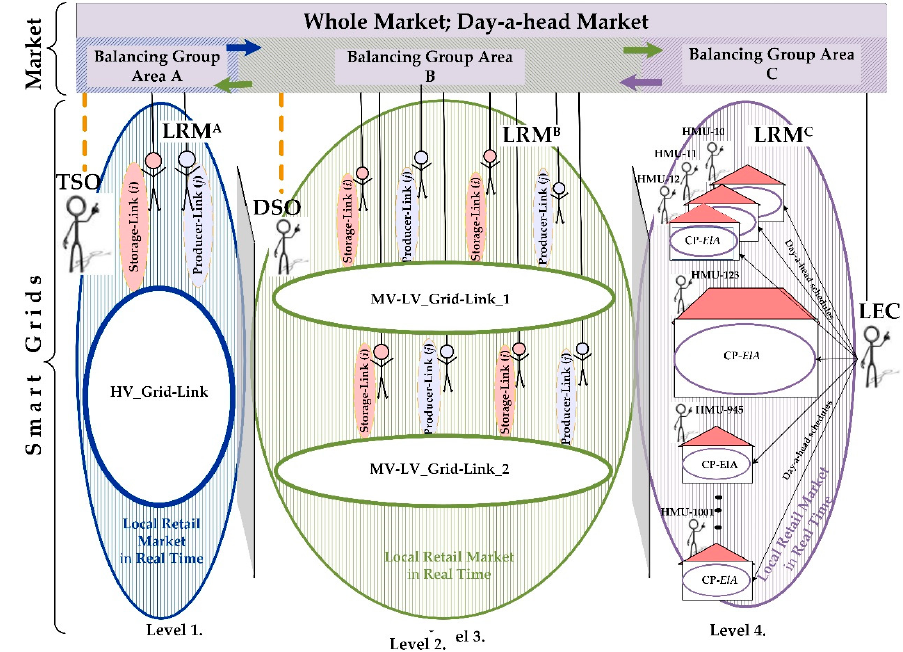
Figure 16. Harmonization of the market structure with the grid link arrangement.